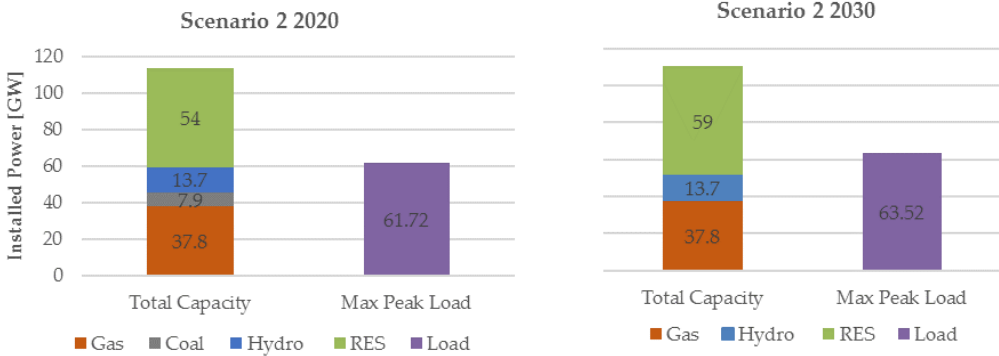
Figure 11. Total installed capacity and max peak load in the years 2020 and 2030 in Scenario 2.